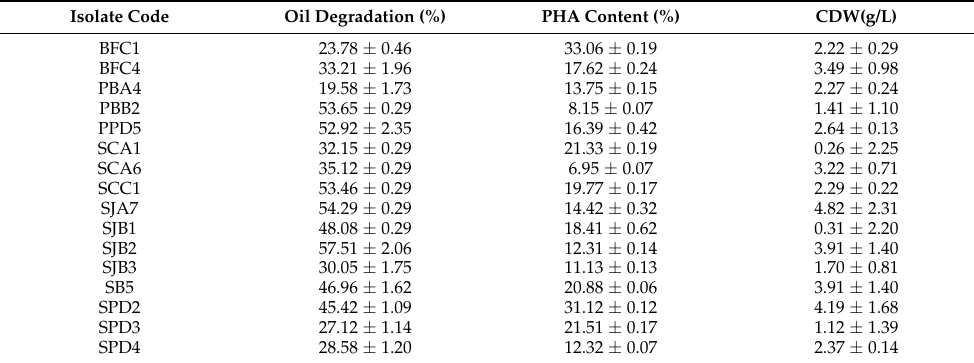
Table 3. The UTO degradation and PHA content of the isolated